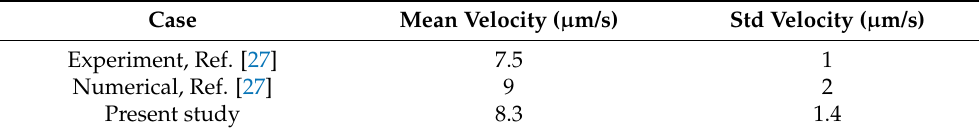
Table 2. Comparison of the present results against experimental and simulation results from Ref. [27] . Case Mean Velocity (μm/s) Std Velocity (μm/s) Experiment, Ref. [27] 7.5 1 Numerical, Ref. [27] 9 2 Present study 8.3 1.4